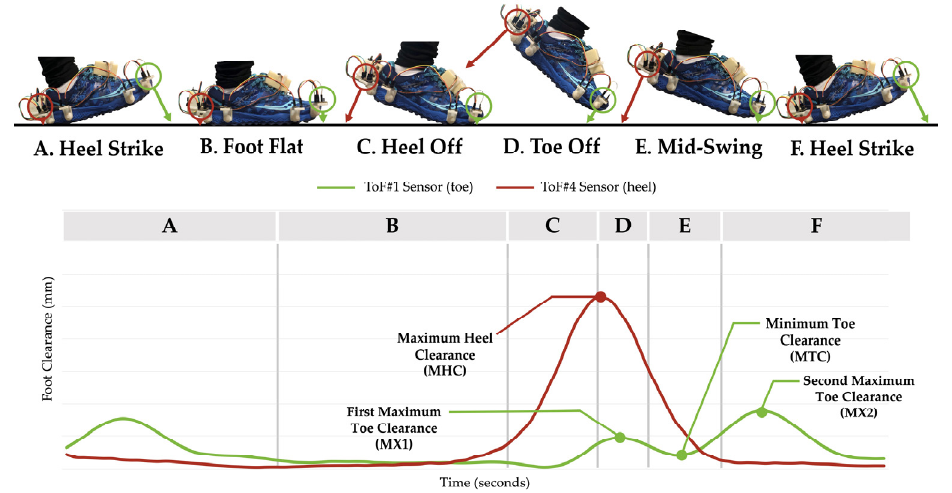
Figure 3. An example of a typical foot clearance graph with the key foot clearance parameters measured by the two ToF sensors located at the toe and heel. The arrows pointing from each ToF sensor represent the foot clearance measured at each phase of the gait cycle. Sections A to F represent each phase of the gait cycle.